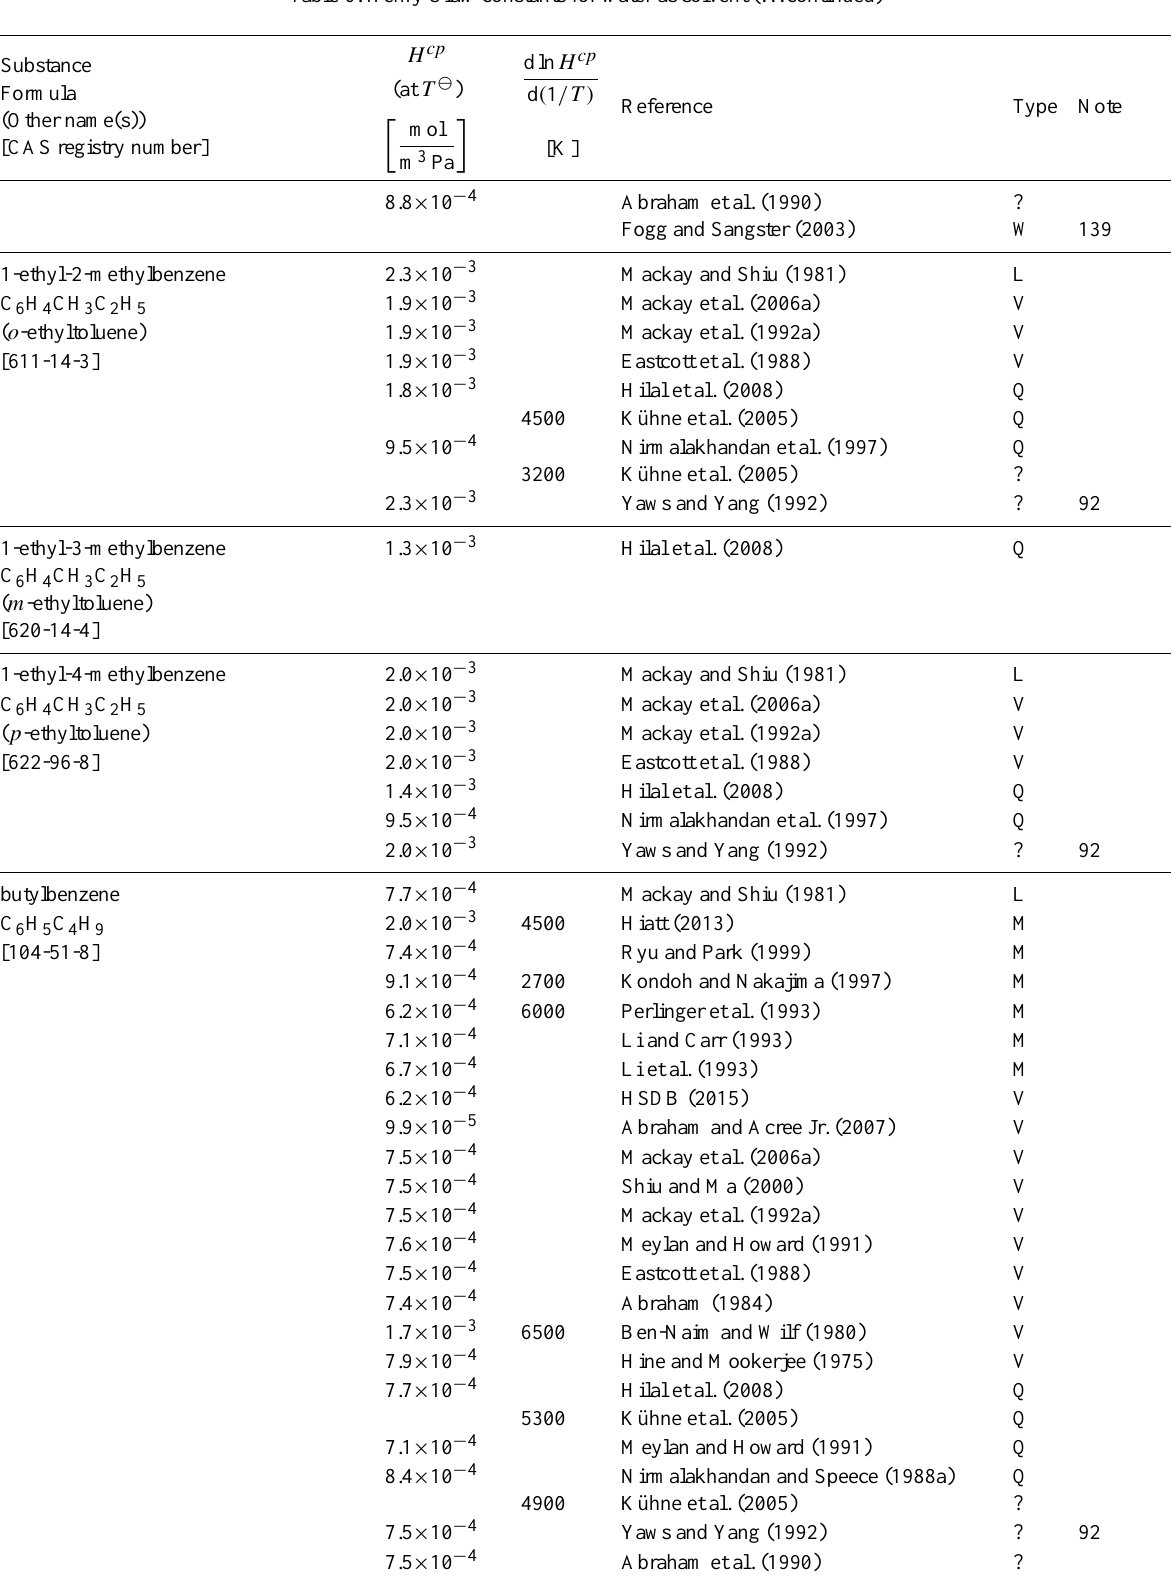
Table 6: Henry’s law constants for water as solvent